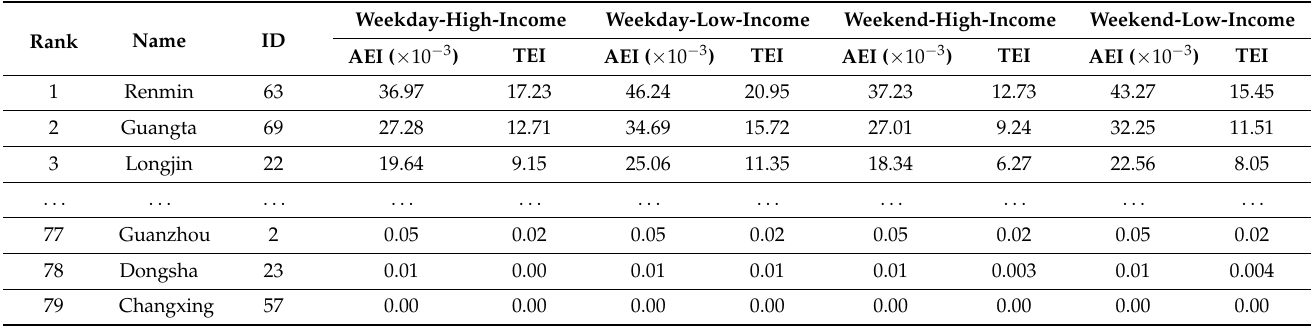
Table 3. The subdistricts with the highest and lowest pandemic